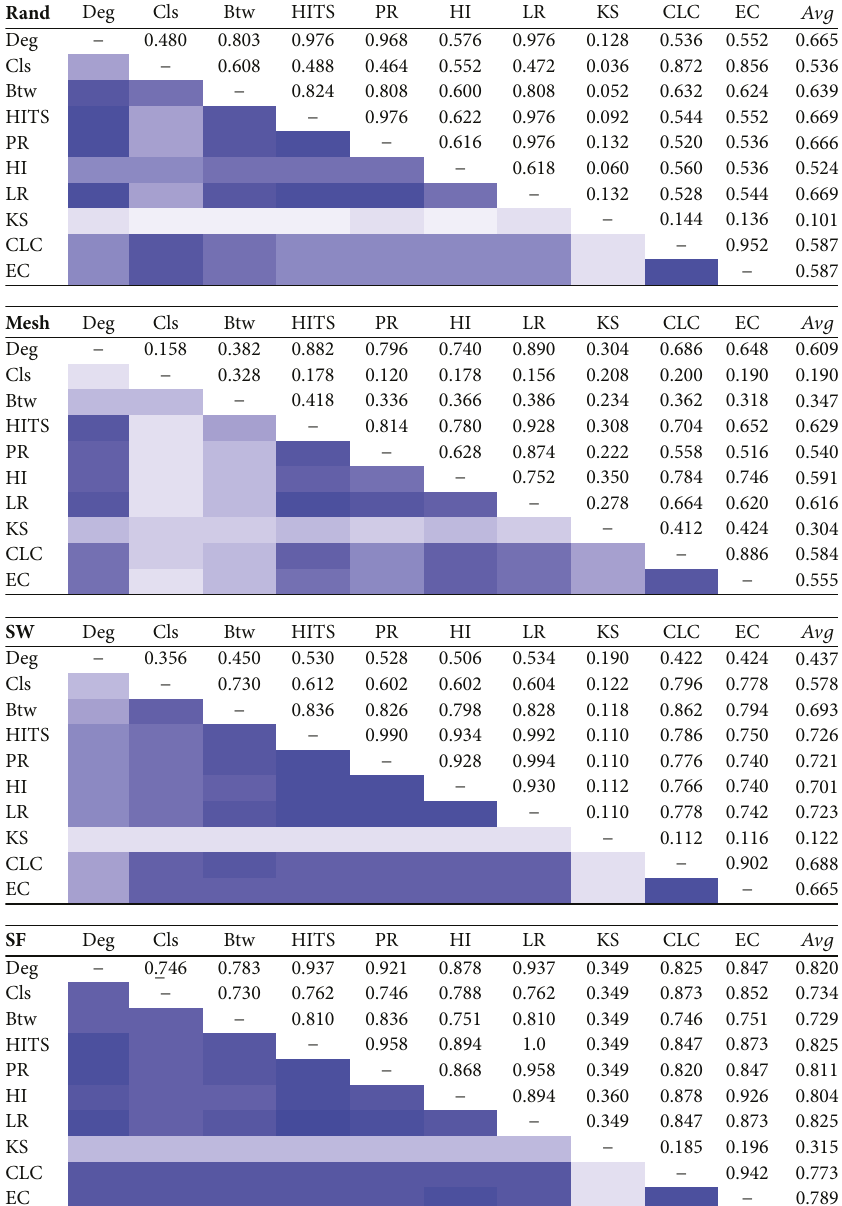
Figure 3: Ratio of nodes overlapping in the top 10% ( N = 10 K nodes) of spreader assignment by 10 centrality metrics (degree, closeness, betweenness, HITS, PageRank, Hirsch index, LeaderRank, k -shell, local centrality, and eigenvector centrality) in an Erdos-Renyi (Rand) random network, mesh network, small-world (SW), and scale-free (SF) network. The blue colour intensity of a cell corresponds to the strength of correlation found in the symmetric cell, that is, cell stronger